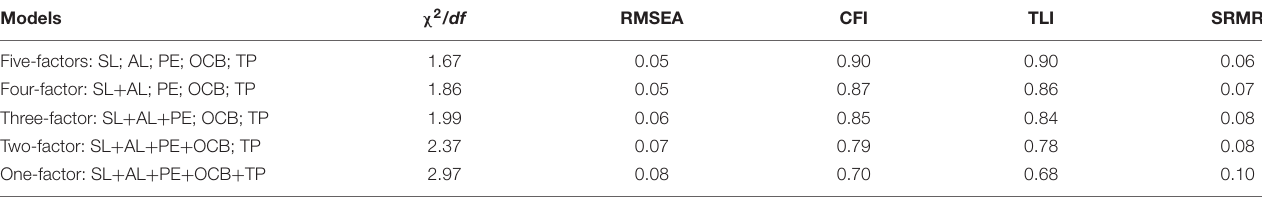
TABLE 2 | Fit indices of each model for validation analysis ( N = 315). Models